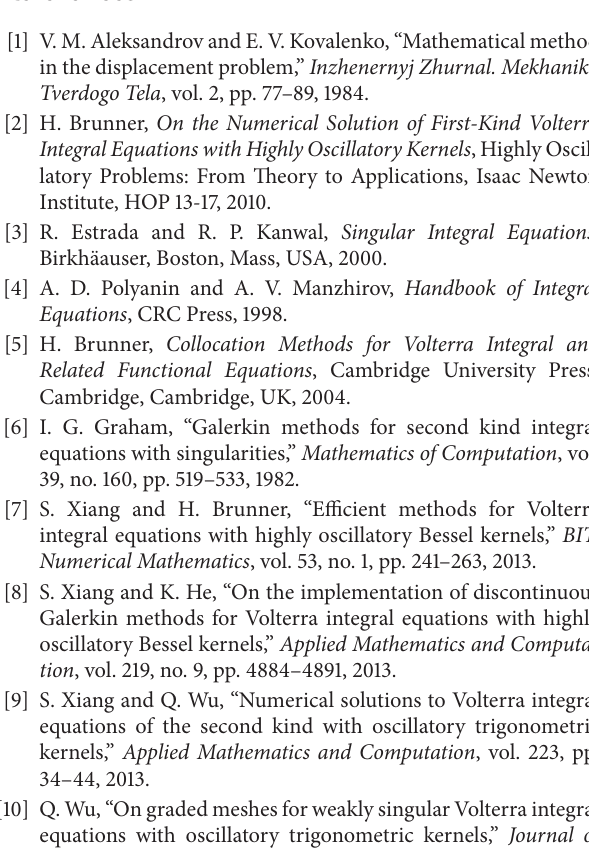
Table 3: Approximations for 𝑦(𝑥) + ∫